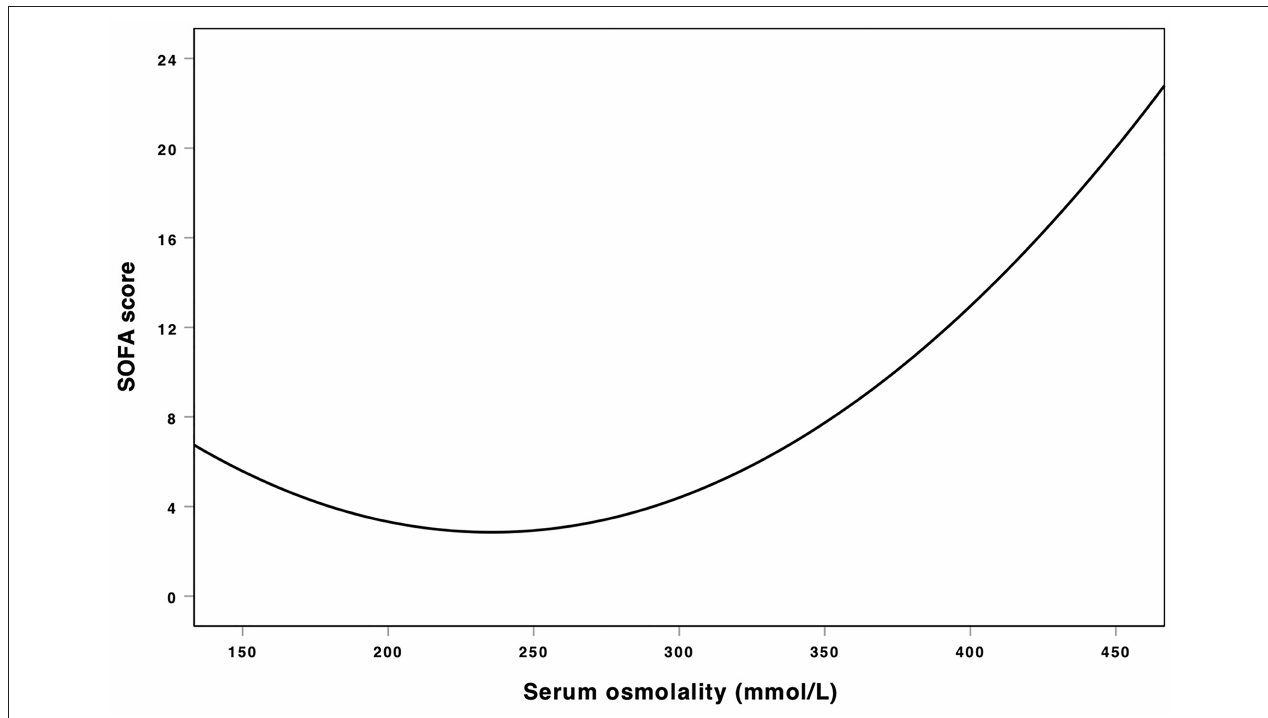
FIGURE 3 | Association between serum osmolality and SOFA score. Non-liner relationships (U-shaped curves) were exhibited in the present figure.